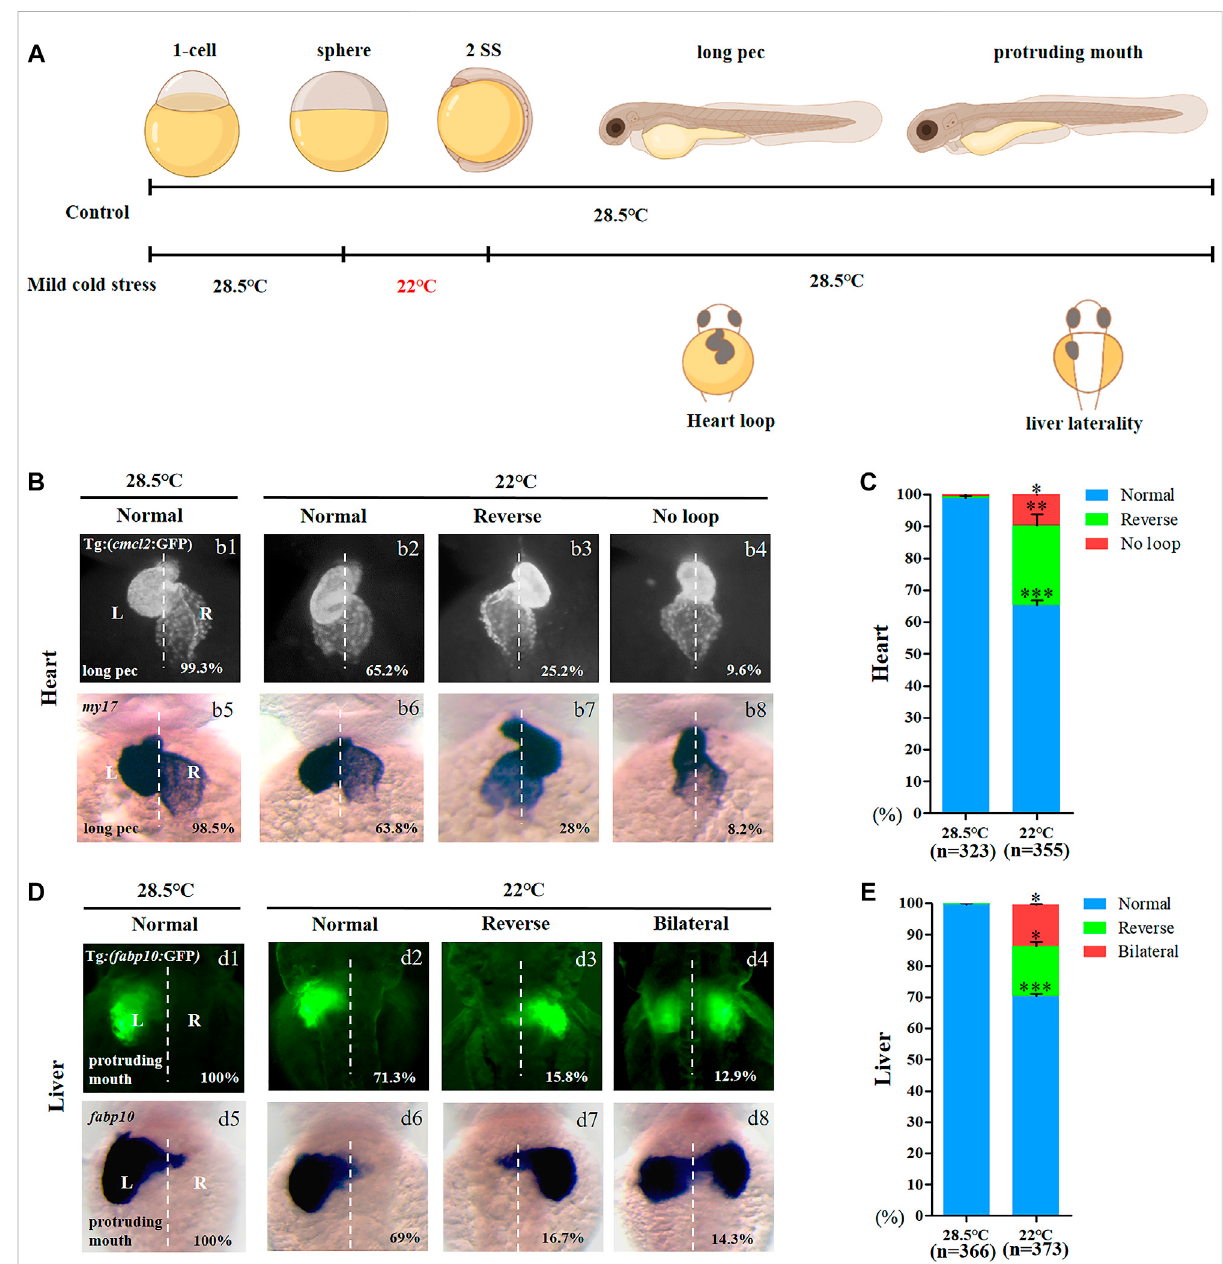
FIGURE 1 Organ left-right patterning defects in embryos treated with mild cold stress. (A) Stage and time diagram of treatment with mild cold stress. (B) Heart morphogenesis in Tg (cmcl2:GFP) transgenic line and wild-type embryos upon cold stress. b1, normal-loop at 28.5 ° C (99.3%, n = 160); b2, normal-loopat22 ° C(65.2%, n =180, p < 0.001);b3,reversed-loopat22 ° C(25.2%, n =180, p < 0.01);b4,noloopat22 ° C(9.6%, n =180, p < 0.04);b5, normal-loop at 28.5 ° C (98.5%, n = 163); b6, normal-loop at 22 ° C (63.8%, n = 175, p < 0.001); b7, reversed-loop at 22 ° C (28%, n = 175, p < 0.01); b8, no loop at 22 ° C (8.2%, n = 175, p < 0.04). (C) Percentages of normal looping, reversed looping, and no looping of the heart in embryos treated at 28.5and 22 ° C.A statisticallysigni fi cantdifference( p < 0.05)couldbeseeninembryos treatedat28.5 vs22 ° C. (D) Mildcoldstresswasfoundto cause liverLRdefectsusingTg(fabp10:GFP)andfabp10probestaining.d1,normalliverat28.5 ° C(100%, n =192);d2,normalliverat22 ° C(71.3%, n =201, p < 0.001); d3, reversed liver at22 ° C (15.8%, n= 201, p < 0.03); d4, liver bi fi da at22 ° C (12.9%, n = 201, p < 0.05); d5,normalliver at28.5 ° C (100%, n= 174); d6,normalliverat22 ° C(69%, n =172, p < 0.001);d7,reversedliverat22 ° C(16.7%, n =172, p < 0.03);d8,liverbi fi daat22 ° C(14.3%, n =172, p < 0.05). (E) Percentagesofnormalliver, reversedliver, andliverbi fi dainembryostreatedat28.5and22 ° C.A statisticallysigni fi cantdifference ( p < 0.05)couldbe seen in embryos treated with 28.5 vs 22 ° C. “ * ” p < 0.05; “ ** “ p < 0.03; and “ *** “ p <